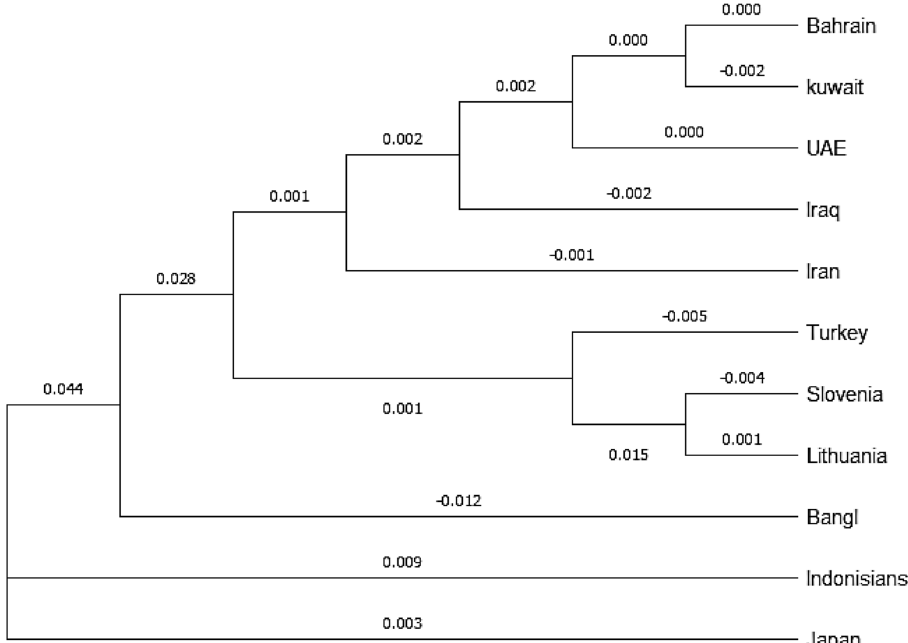
Figure 1. Phylogenetic tree performed using Nei’s DA Distances for the 30 indels estimated among 11 populations.